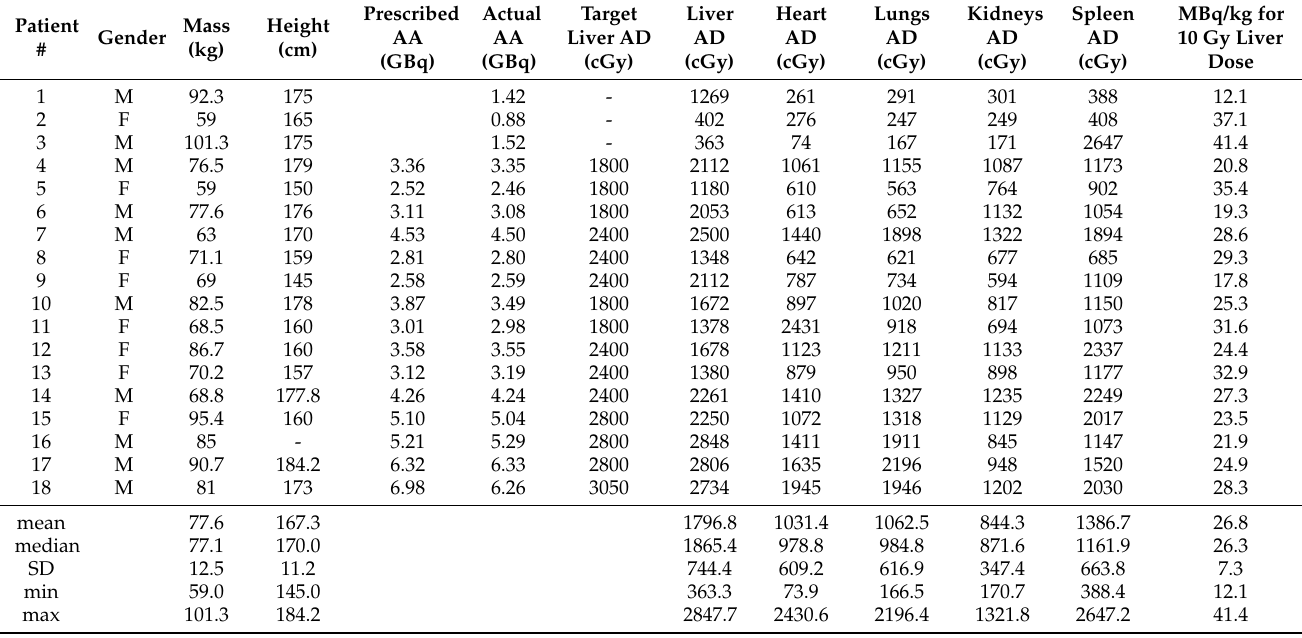
Table 2. Injected radioactivity quantities and targeted major organ radiation doses from these activities. # = patient number. Patient Mass Gender #